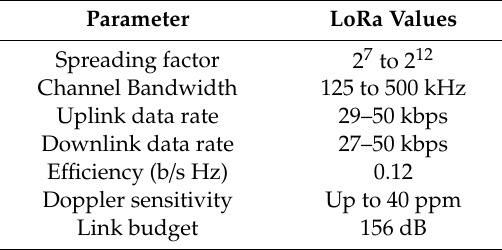
Table 2. The properties of LoRaWAN.